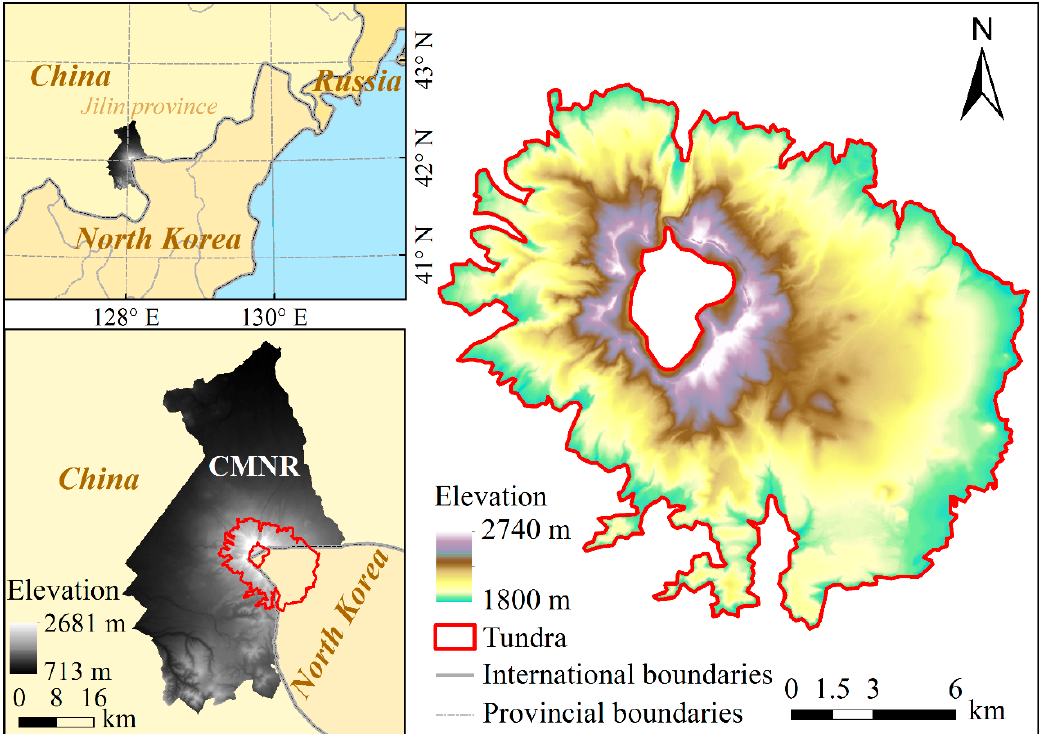
Figure 1. Location of the study area, CMNR representing the Changbai Mountains Nature Reserve.